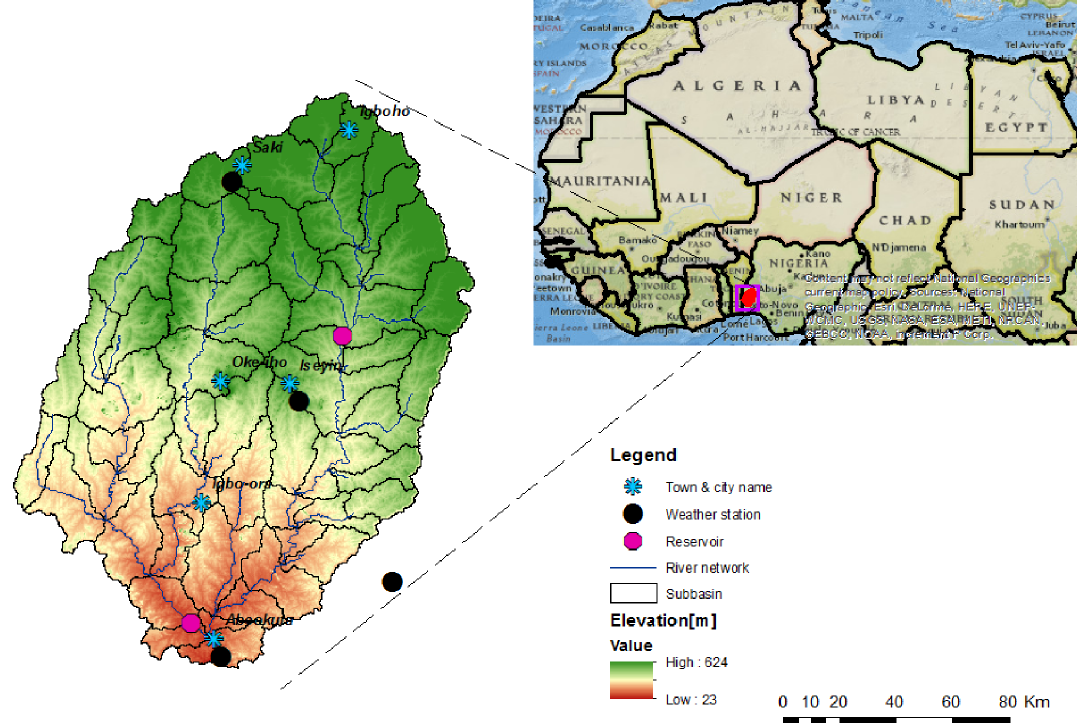
Figure 1. The Ogun River Basin located in Nigeria showing the SWAT-delineated subbasins, weather stations and river network.